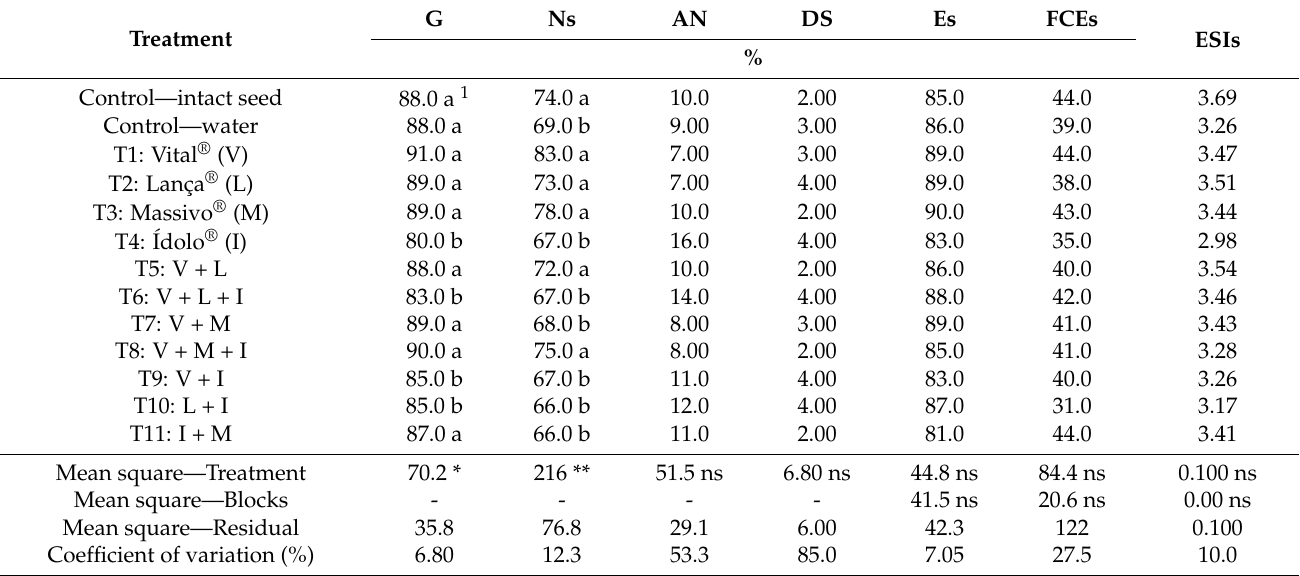
Table 1. Germination (G), strong normal seedlings (Ns), abnormal seedlings (AN), dead seeds (DS), seedling emergence in sand (Es), first count (FCEs), and seedling emergence speed index in sand (ESIs) of soybean NS7667 IPRO from different seed treatments. Jata í , GO, Brazil,